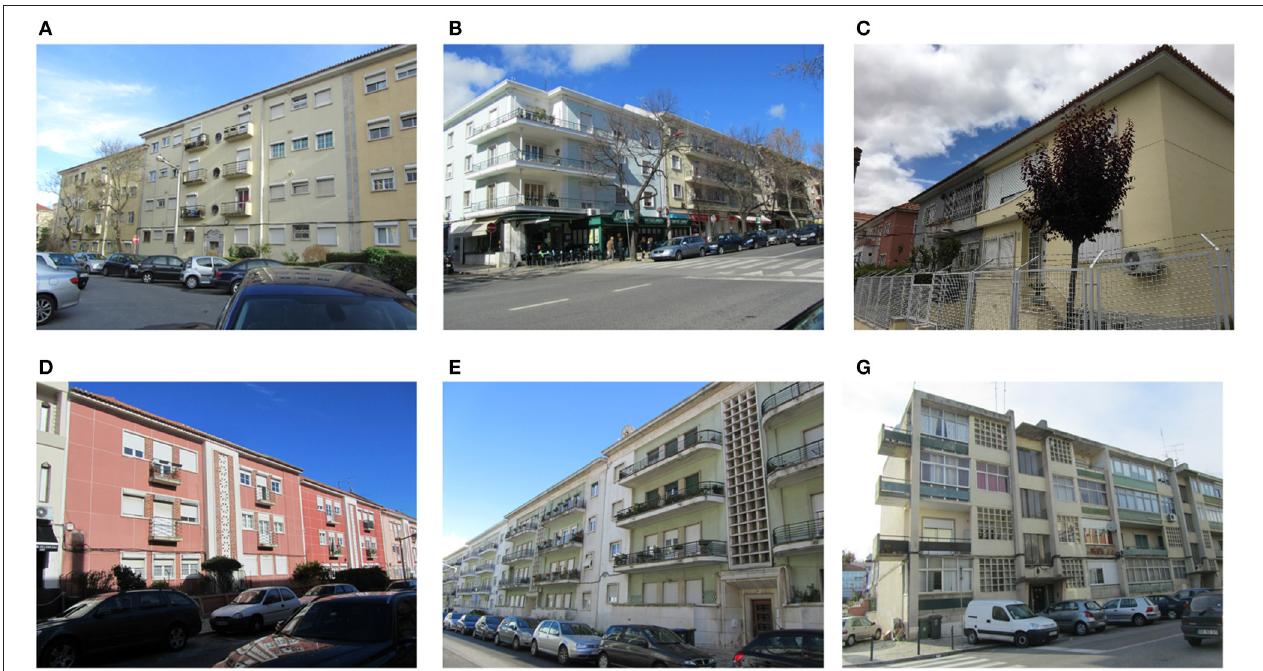
FIGURE 4 | Buildings from different cells. (A) Buildings in Cells I and II. (B) Buildings in Cell III. (C) Buildings in Cell IV. (D) Buildings in Cell V and VI. (E) Buildings in Cell VII. (F) Buildings in Cell